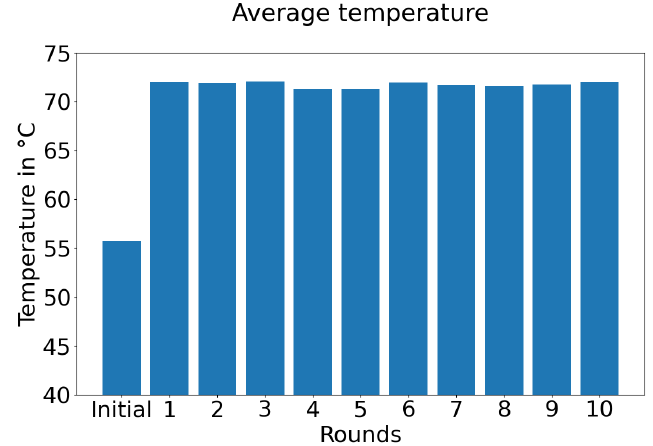
Figure 5. Average temperature in Raspberry Pi devices from federated semi-supervised learning experiment with aggregation technique “simple”.